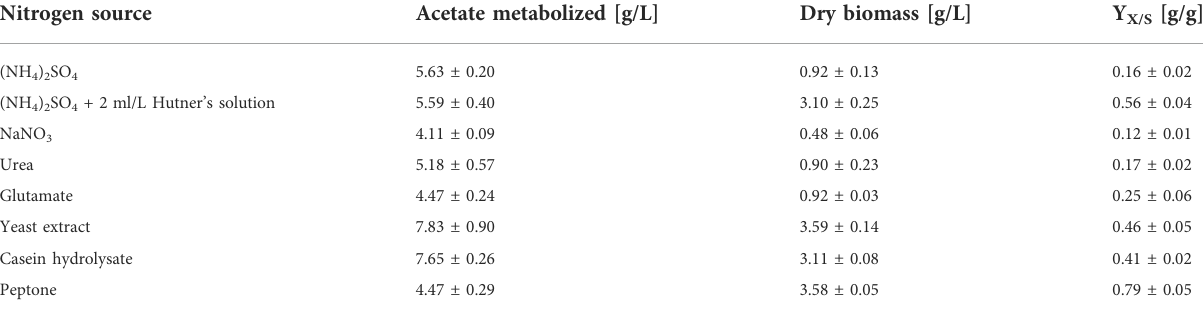
TABLE 2 Comparison of growth of A. oryzae after 48 h of cultivation in pre-culture medium with different nitrogen sources. Values are means ± standard deviation, n = 3. Nitrogen